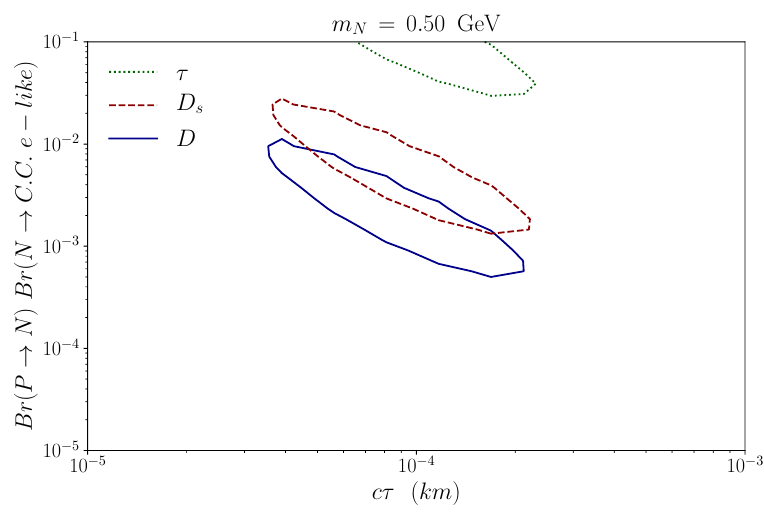
Figure 18 . 1 (cid:27) best-(cid:12)t regions for HNL decays in IceCube assuming uncorrelated Br( P ! N ) vs c(cid:28) for m N = 0 : 5 GeV and considering separately the production from three parent particles P = D; D s ; (cid:28)